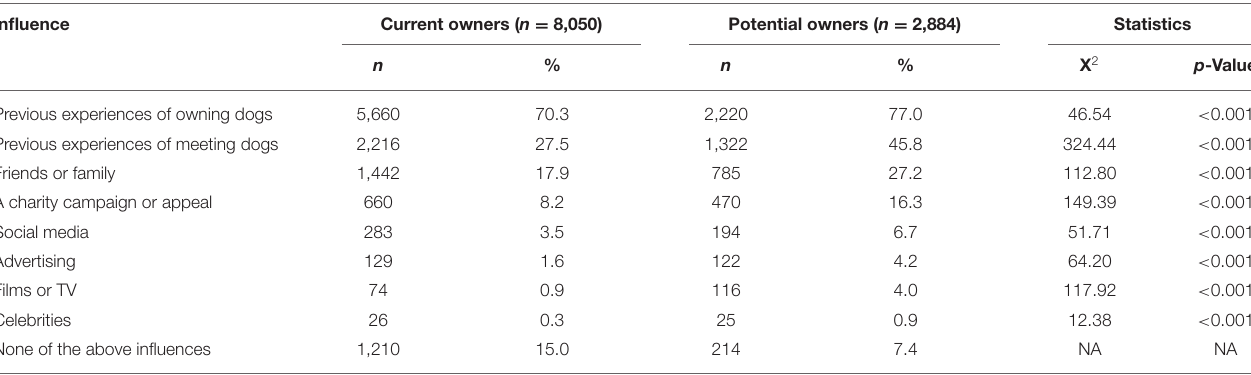
TABLE 4 | Influences when deciding to get a